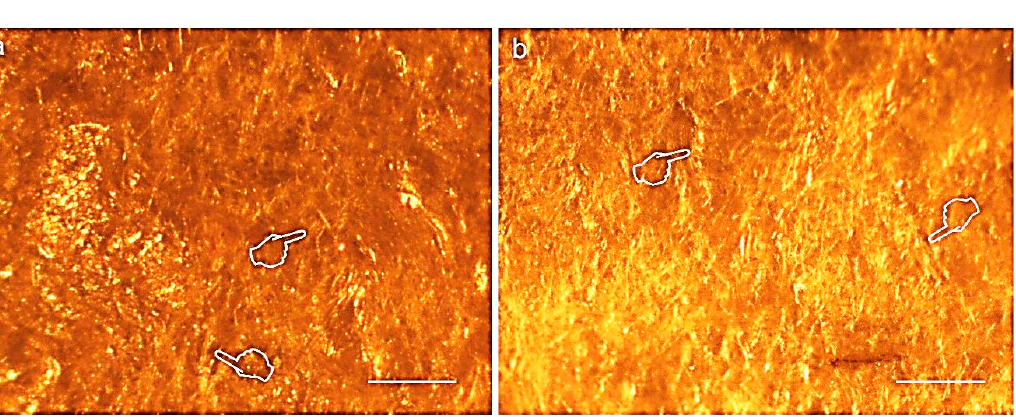
Figure 4. Representative light micrographs of surfaces of Evolution standard membrane at the outer ( a · I), inner ( a · II, b ) surfaces before immersion and at the inner surfaces after trypsin ( c ) and PBS ( d ) immersion, at 21 d of storage. The ondulating collagen fibers and microfibrils were arranged in stacked layers, which were parallel to the membrane surface (single arrows). Collagen fibrils formed fine, loosely arranged, undulating collagen bundles. The packing of fibrils into fibers was not very tight, resulting in single fibrils or small bundles interconnecting larger bundles. Isolated fibrils running crosswise formed a loose meshwork overlying the bundled fibrils. Multiple grooves, pits and pores (pointers) were seen at the inner surface of the membrane. Scale bar is 1000 µm in ( a ·I), ( a ·II), ( c) , ( d) and 2000 µm in ( b ).